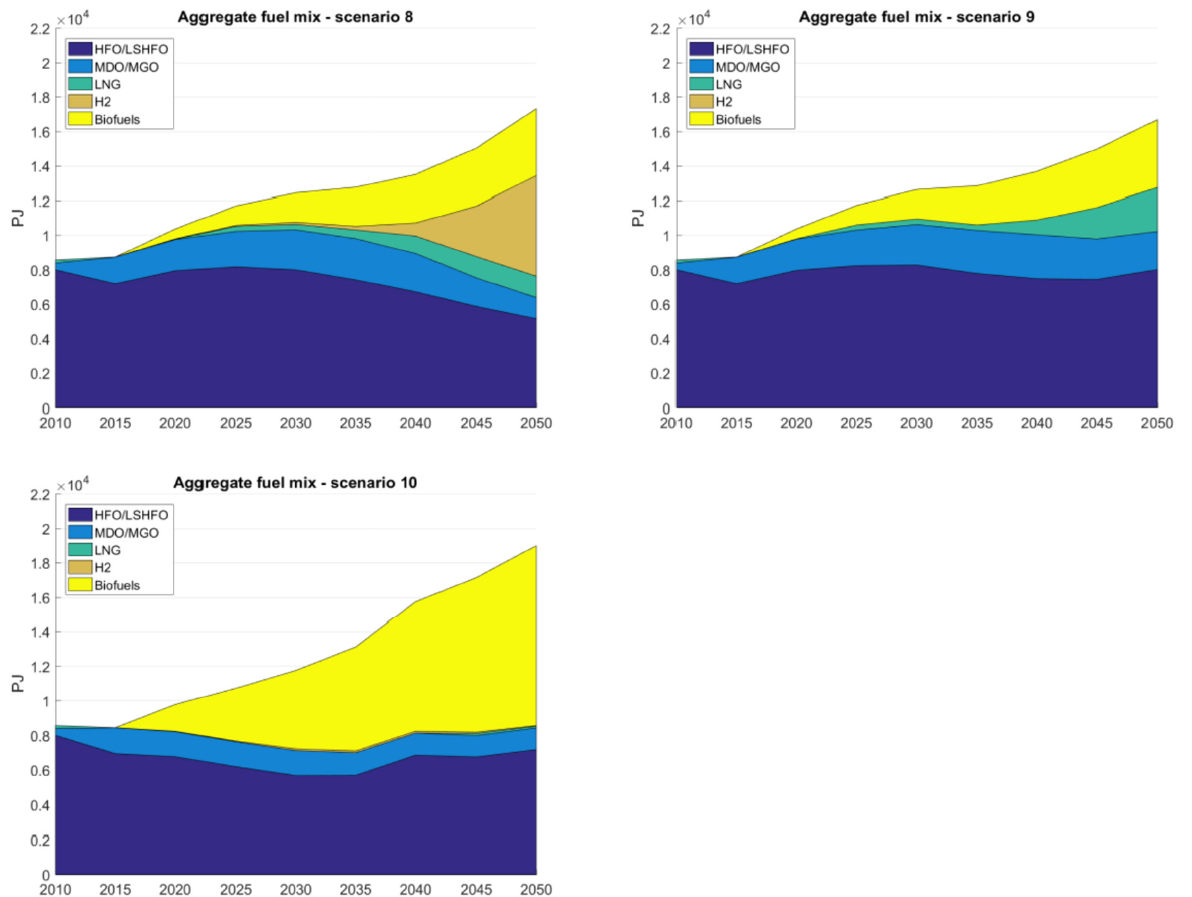
Figure 10. Scenario-based evolution of aggregate maritime fuel mix. Note: One petajoule (PJ) equals 1,000,000,000,000,000 joules (10 to the power of 15). A Joule is a unit of energy equaling 0.24 calories. 1 PJ = 31.6 million m 3 of natural gas, or 278 million kilowatt hours of electricity. Source: [37]. Table 2. Marine fuel price predictions from Lloyds Register and UMAS (2020) in USD/GJ. Primary Energy